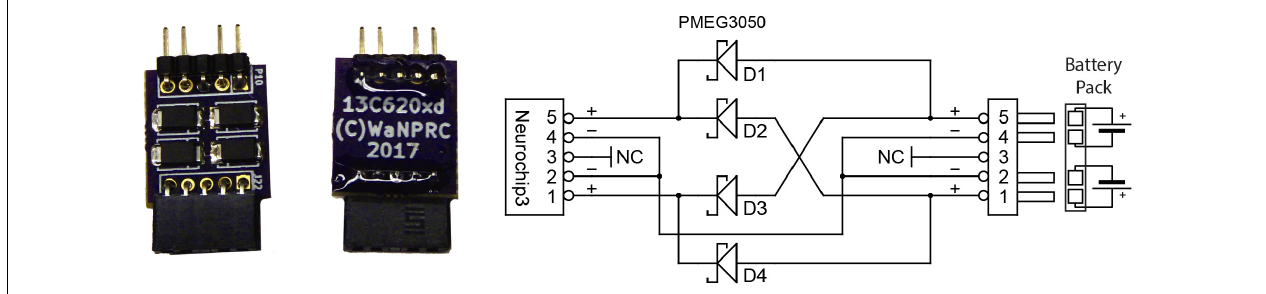
FIGURE 3 | Optional battery combiner circuit uses four Schottky barrier rectifiers to allow full discharge of both batteries at only a small loss in total power delivered to the NC3.